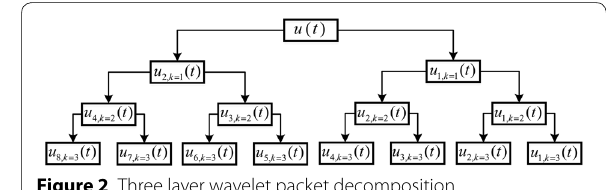
Figure 2 Three layer wavelet packet decomposition